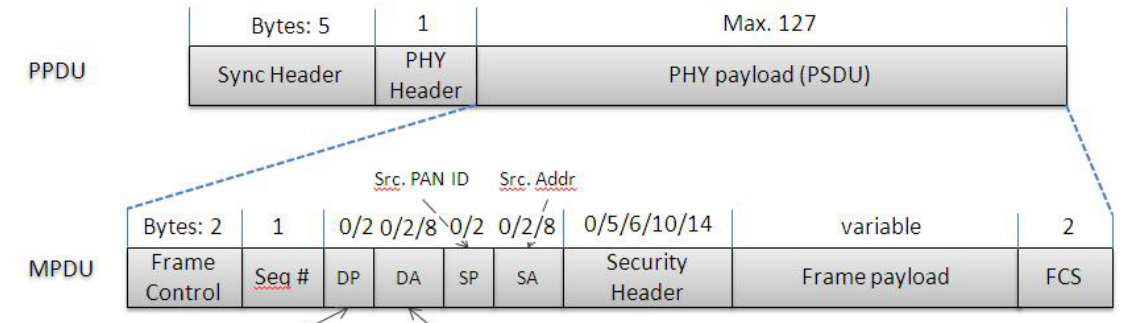
Figure 3. IEEE 802.15.4 The Physical Protocol Data Unit (PPDU) and MAC Protocol Data Unit (MPDU)